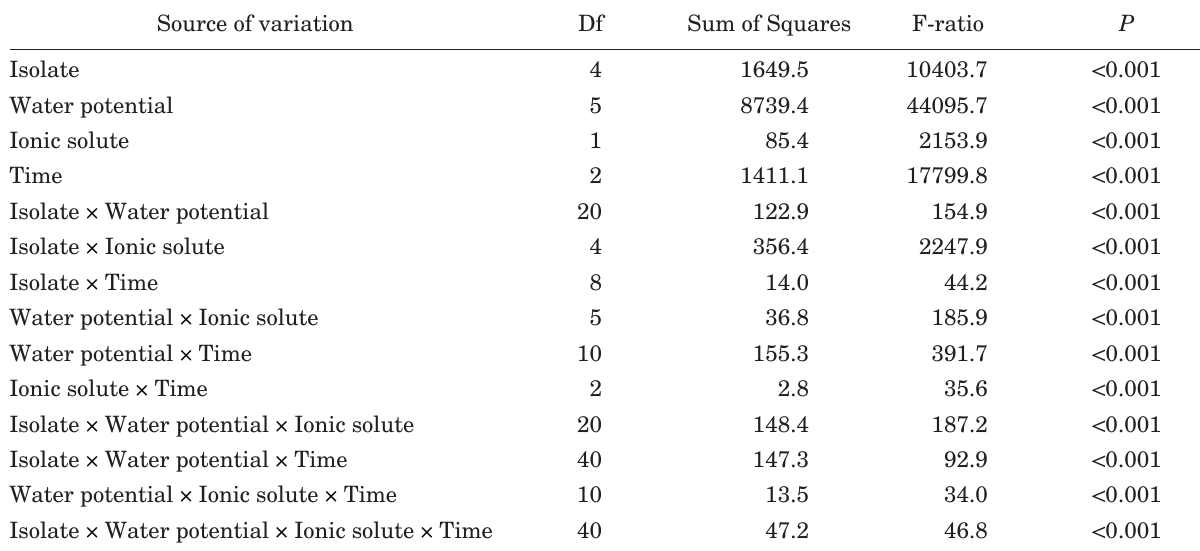
Table 1. Analysis of variance of all the main factors (isolate, water potential, ionic solute and time) and of their interactions on colony